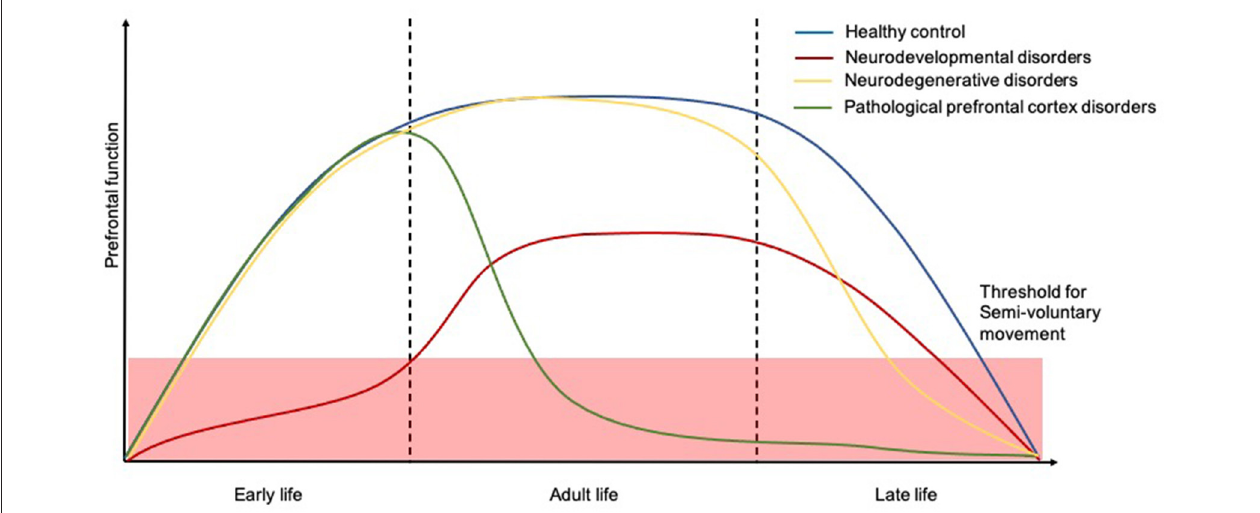
FIGURE 4 | Temporal trajectories of the relationship between human prefrontal function and course of semivoluntary movement. The x -axis shows time and the y -axis shows the relative human prefrontal function. The schematic illustrates how prefrontal function in people with neurodevelopmental disorders (red), neurodegenerative disorders (yellow), and other pathological prefrontal cortex disorders (green) might decline, for which the semivoluntary movement (under the threshold) will begin to emerge compared to healthy population